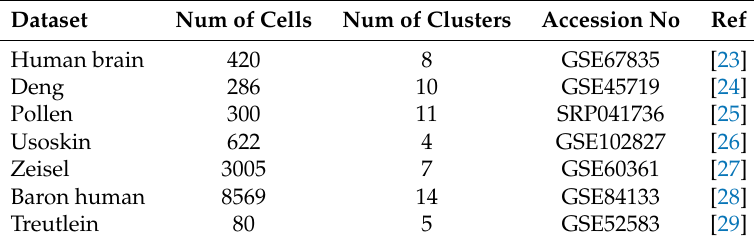
Table 1. The scRNA-seq datasets used for